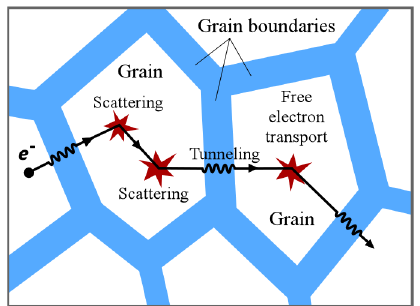
Figure 2. Schematic view of carrier transport within grains (intragrain) and through grain boundaries (intergrain) in nanomaterials